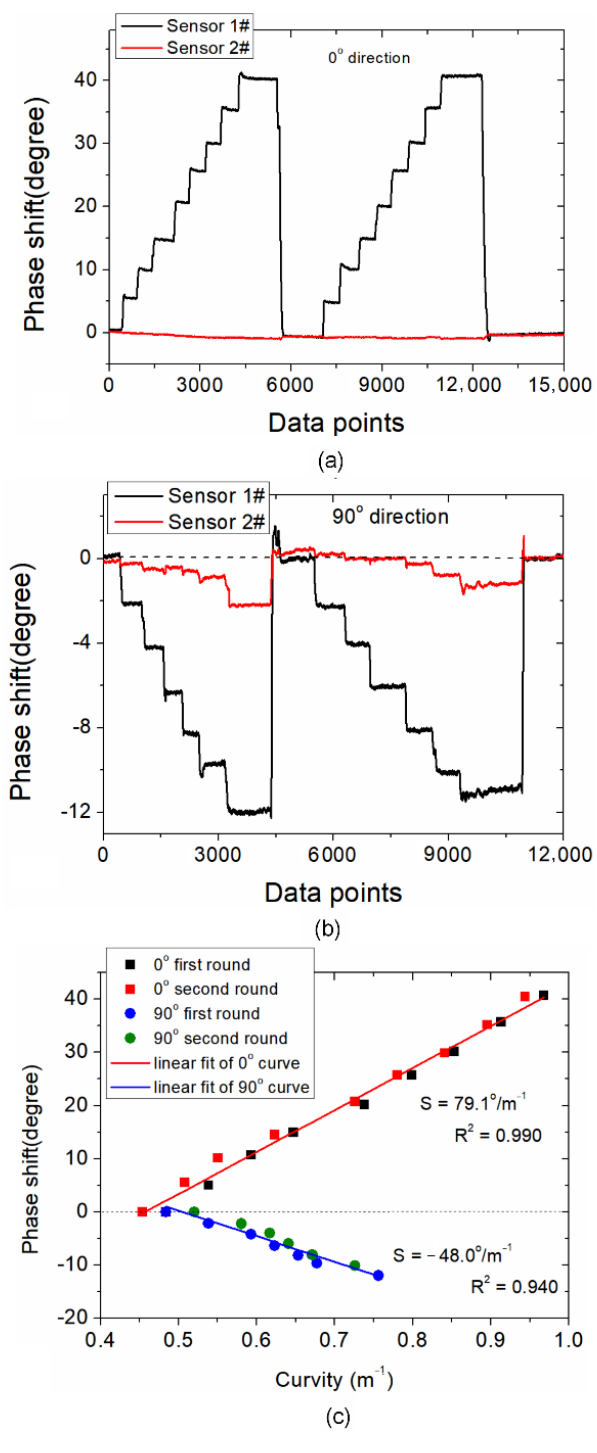
Figure 6. Phase responses of the WWFT-based interferometer 1# and sensor 2# in ( a ) 0° direction and ( b ) 90° direction; ( c ) Phase shift versus curvature in 0° and 90° direction.